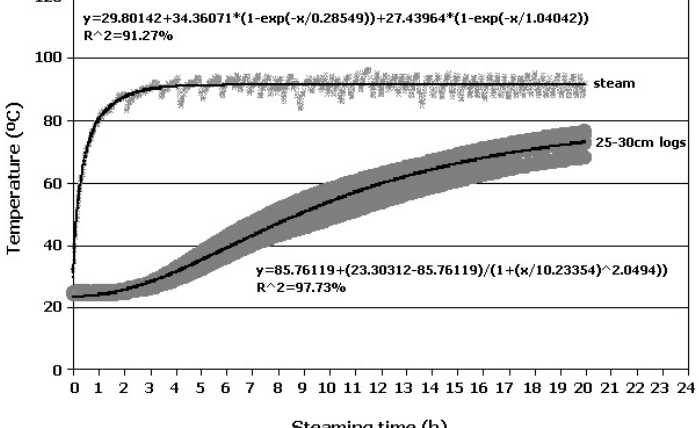
Fig. 3 – Logistics S-shaped curve adjusted for the temperature in the Eucalyptus grandis logs center classified between 25 and < 30 cm diameter during steaming.